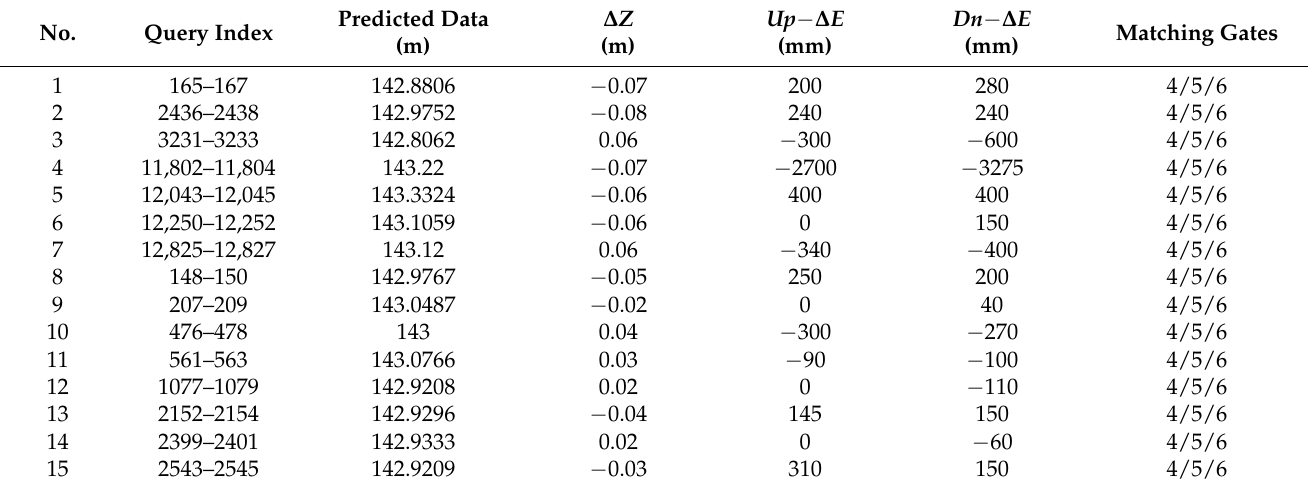
Table 7. Queries and corresponding information.